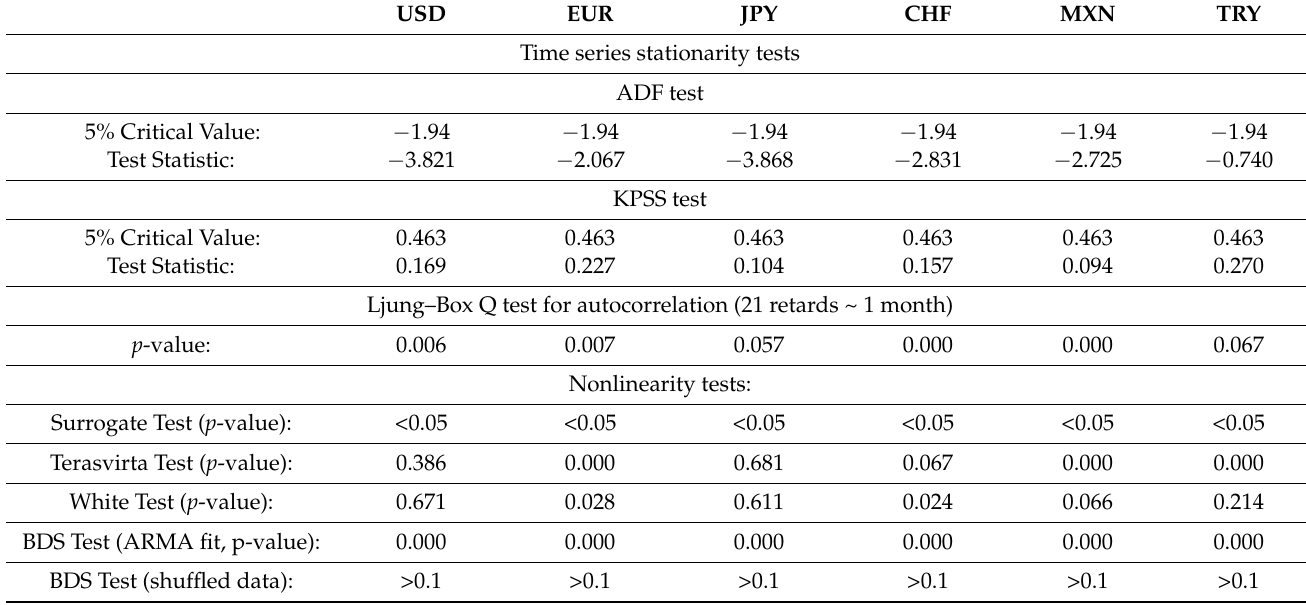
Table 3. Summary of the stationarity, time-dependence and non-linearity analysis of the daily Polish zloty exchange rate returns